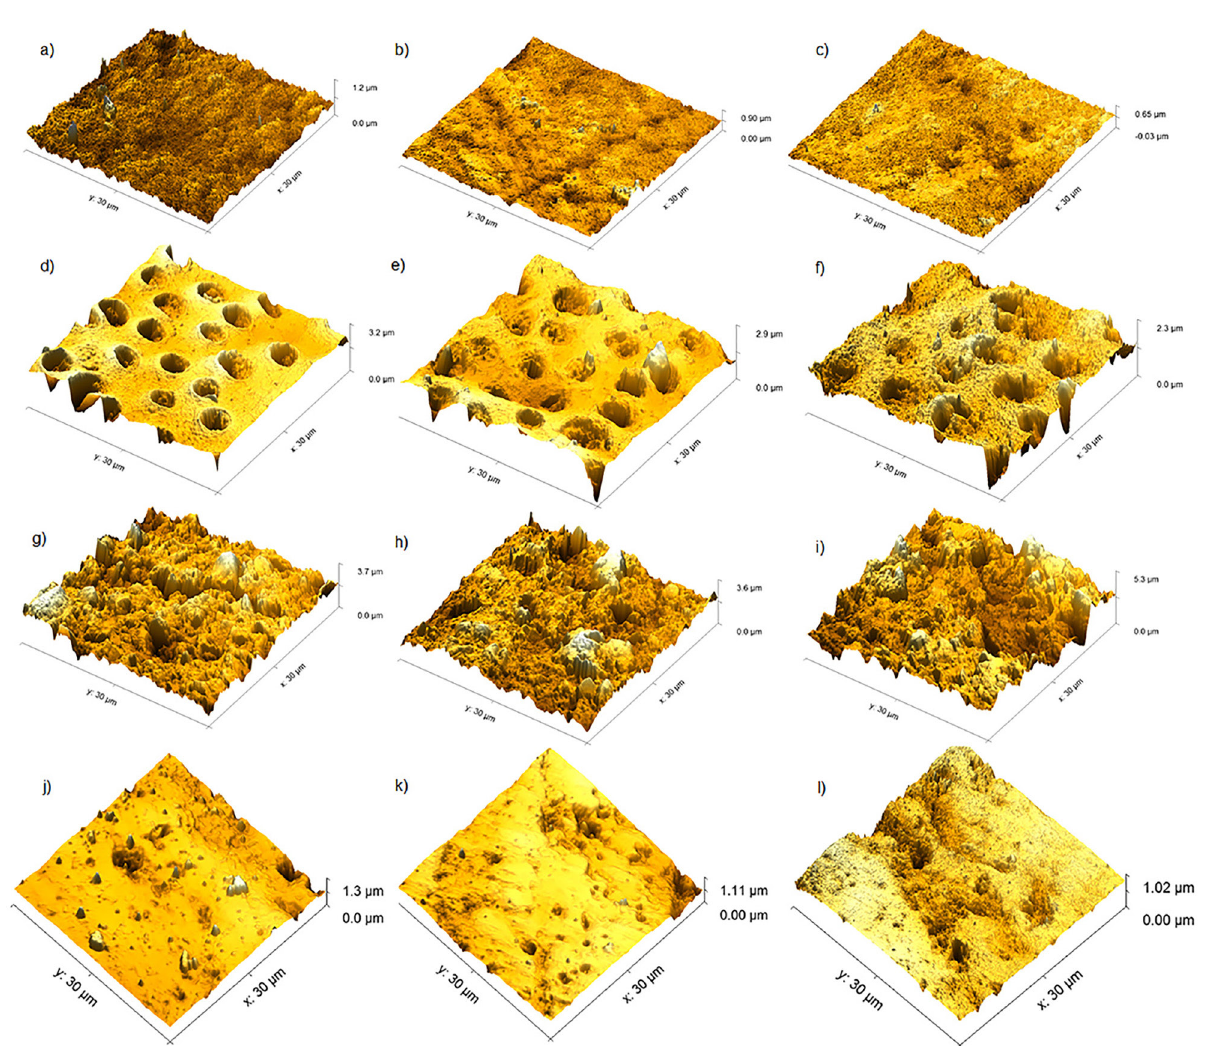
Figure 3- Representative AFM images (256×256 pixels) of enamel, dentin, and restorative